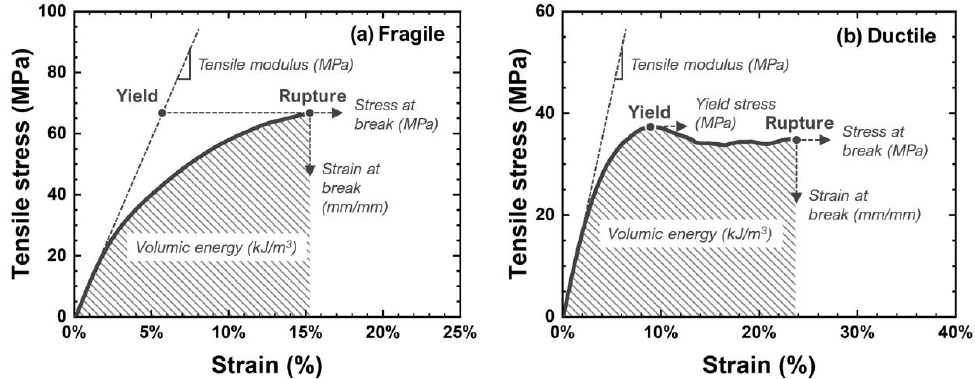
Figure 3. Exploitation of stress-strain curves in the case of fragile epoxies ( a ) and ductile epoxies ( b ).